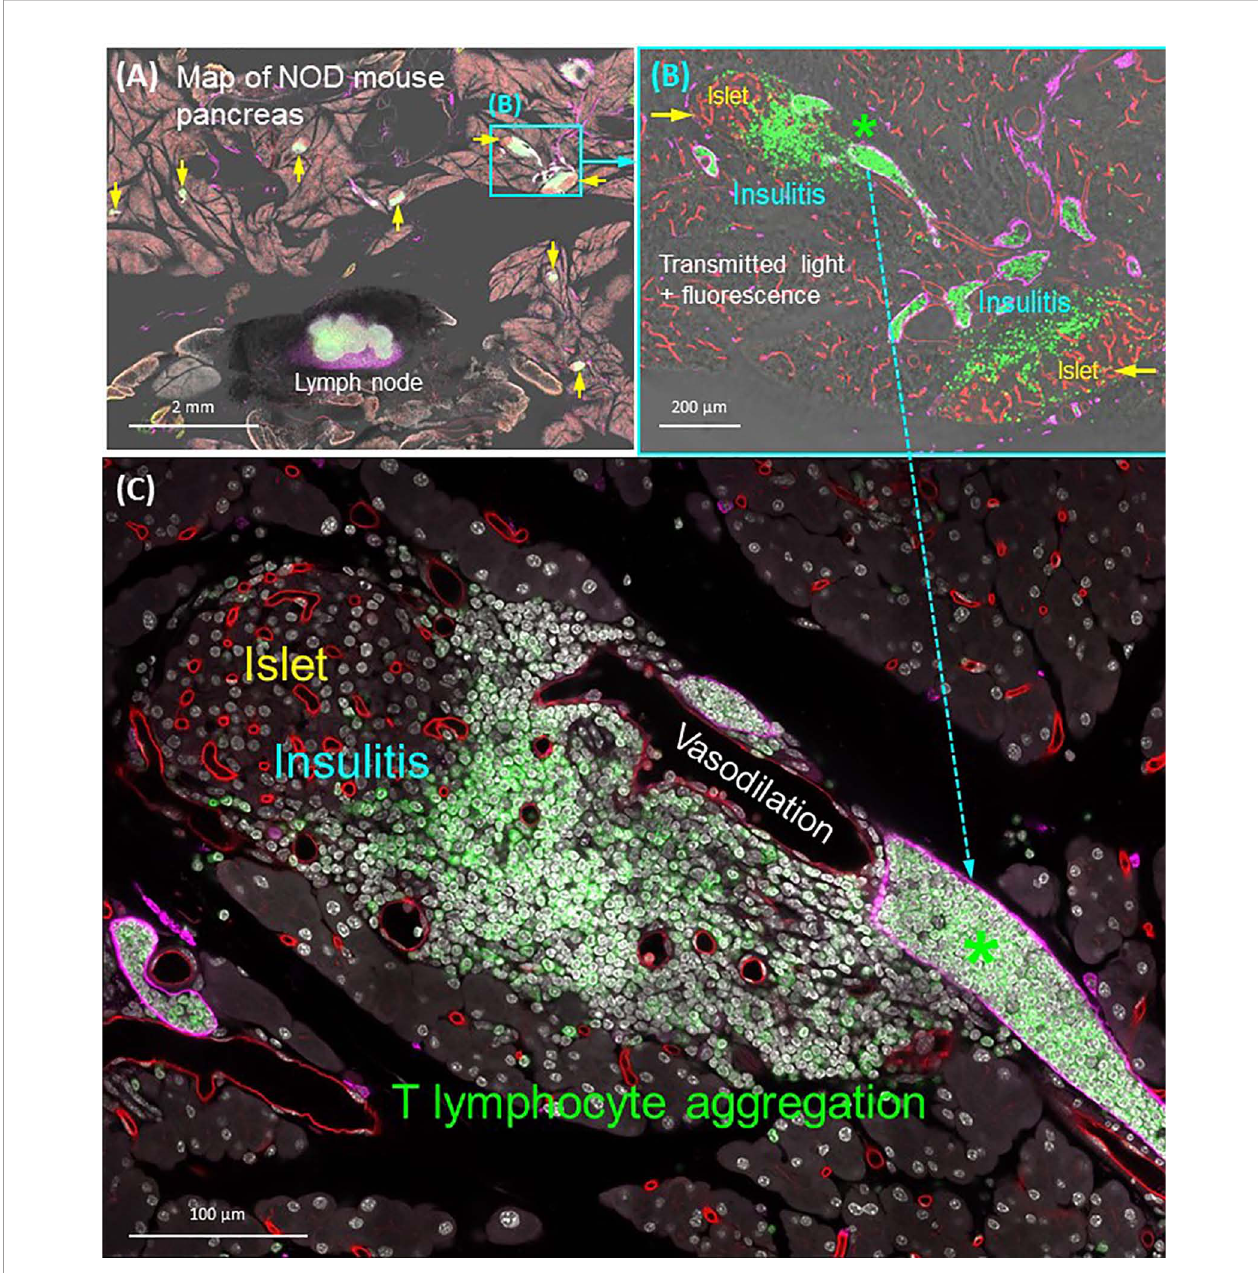
FIGURE 7 | Panoramic and high-resolution images of optically cleared NOD mouse pancreas with insulitis. (A) Map of 8-week NOD mouse pancreas. Overlay of transmitted light and fl uorescence signals identi fi es the Lyve1 + lymph node ( fi lled with CD3 + T lymphocytes and surrounded by fats) and locations of insulitic islets (yellow arrows). Two islets (cyan box) are magni fi ed in (B) . (B) Islets with insulitis are shown with blood vessels (red), lymphatic vessels (magenta), and nuclei (white). CD3 + T lymphocytes are identi fi ed around the islets and congregated in the lymphatic vessels (asterisk; vascular compartment vs. extravascular domain). This feature is further magni fi ed in (C) . (C) Peri-islet aggregation of T lymphocytes and their vascular association shown as well as the peri-islet vasodilation and lymphocytic in fi ltration. See also Supplementary Video 5 for (B)